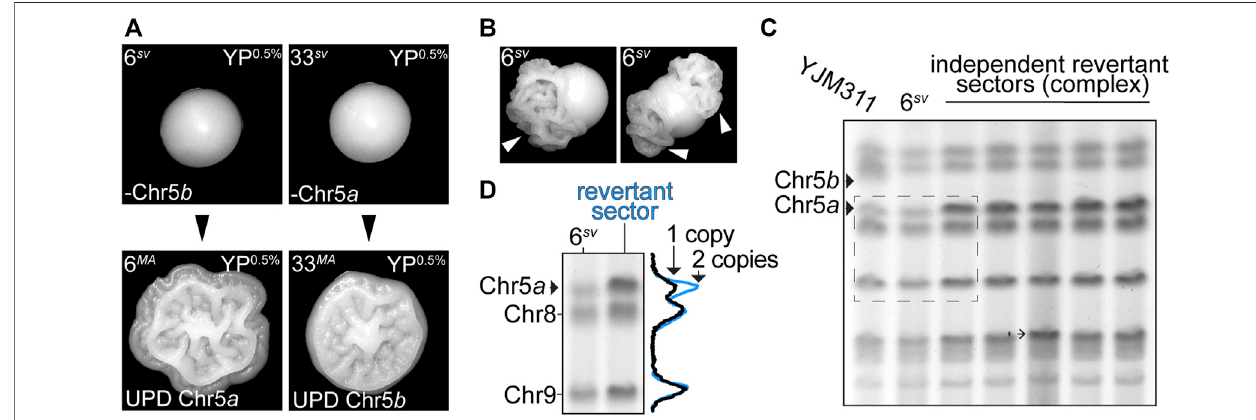
FIGURE4| Phenotypic reversionsare drivenby subsequent aneuploidization events. (A) . Representative images ofcolonymorphologies ofvariant clones 6 sv and 33 sv and their respective MA-derivatives 6 MA and 33 MA when grown on YP 0.5% . (B) . Representative images of sectored colonies derived from 6 sv . (C) . Molecular karyotypes of the parental YJM311 genome, the smooth variant 6 sv , and fi ve revertant sectors recovered from independent colonies. Solid arrowheads denote the bandscorrelatingtothetwohomologsofChr5(Chr5 a ,Chr5 b ).6 sv lostChr5 b .BarbedarrowheadsdenoteadditionalSVsthataroseconcurrentlyinthegenomesof revertantsectors. (D) . Band intensity tracing analysis and representative crop from (C) . (dashed rectangle)con fi rming UPD ofChr5 a in revertant complex sectors. Black trace represents band intensity derived from 6 sv , blue trace represents band intensities derived from complex sectors. The increased amplitude of the blue peak corresponding to Chr5 a correlates with an increase in copy number from 1 to 2